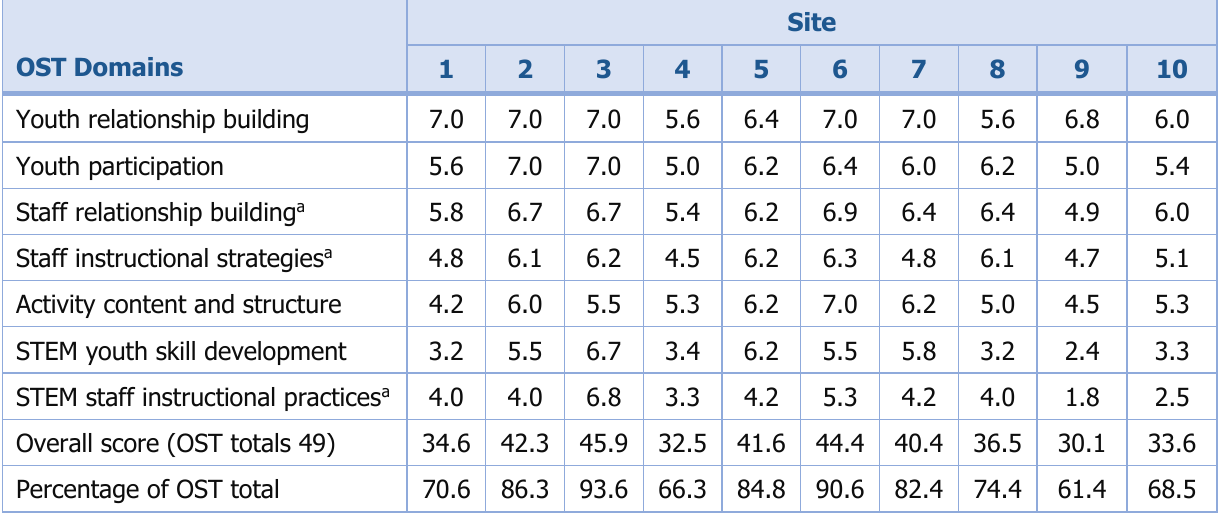
Table 2. Out-of-School-Time Observation Instrument With STEM Plug-In Scores